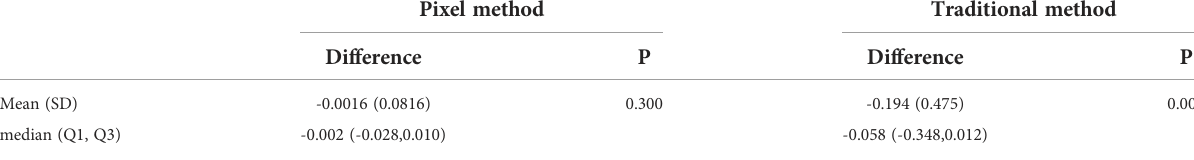
difference values were compared using the signed rank